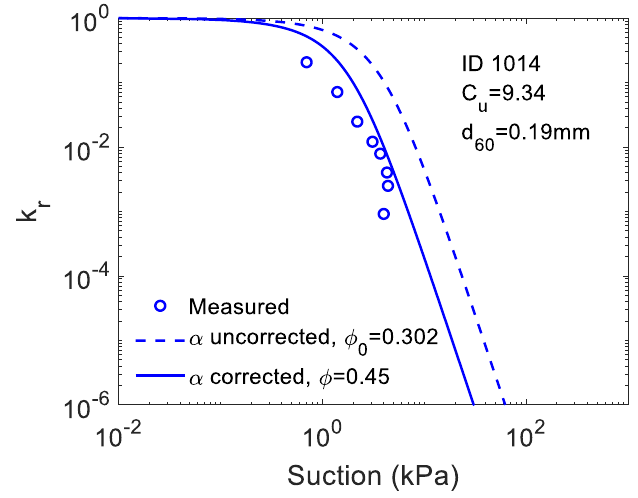
Figure 9. Comparison of model performance between using the original estimation of 𝛼 (Equation (15)) and using the corrected estimation of 𝛼 (Equation (19)) (experimental measurements are based on the instantaneous profile method). Water 2019 , 11 , x FOR PEER REVIEW